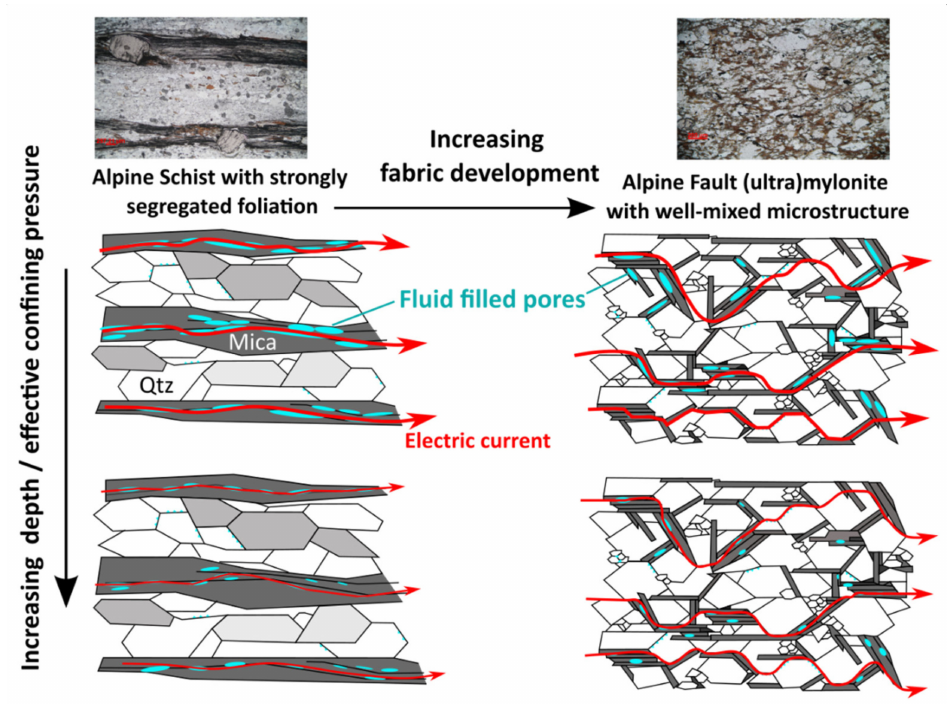
Figure 8. Schematic illustrations of microporosity, showing how differential porosity closure may explain the observed change in anisotropy of resistivity with effective confining pressure δ ( ρ (cid:107) / ρ ⊥ )/ δ (p eff ). Compliant pores in phyllosilicate foliation domains impose an anisotropic permeability, and thus resistivity, in the Alpine Schists. Conversely, in Alpine mylonite and ultramylonite, both com- pliant and non-compliant pores lack a preferential orientation, so their closure has a less significant effect on the change in anisotropy of resistivity with increasing effective confining pressure. This is denoted by a decrease in electric current arrow size in the diagram for the two samples with increasing effective confining